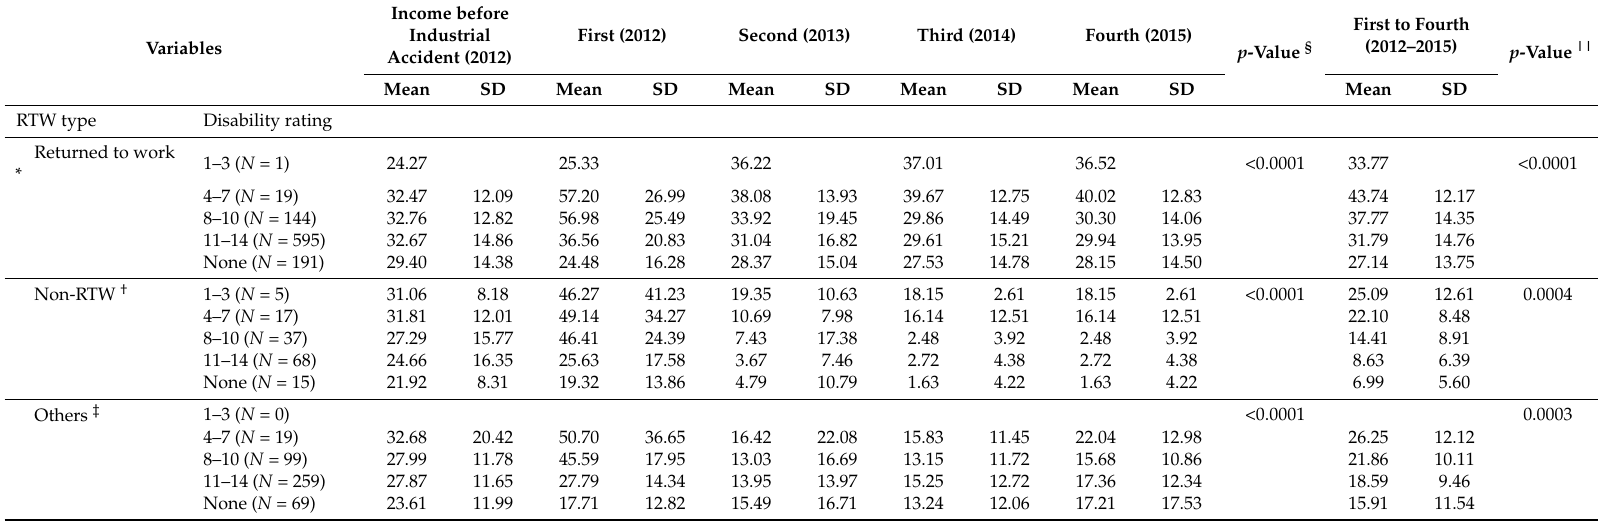
Table 3. Annual income characteristics between the participation of economic activities and disability rating (unit: million KRW).